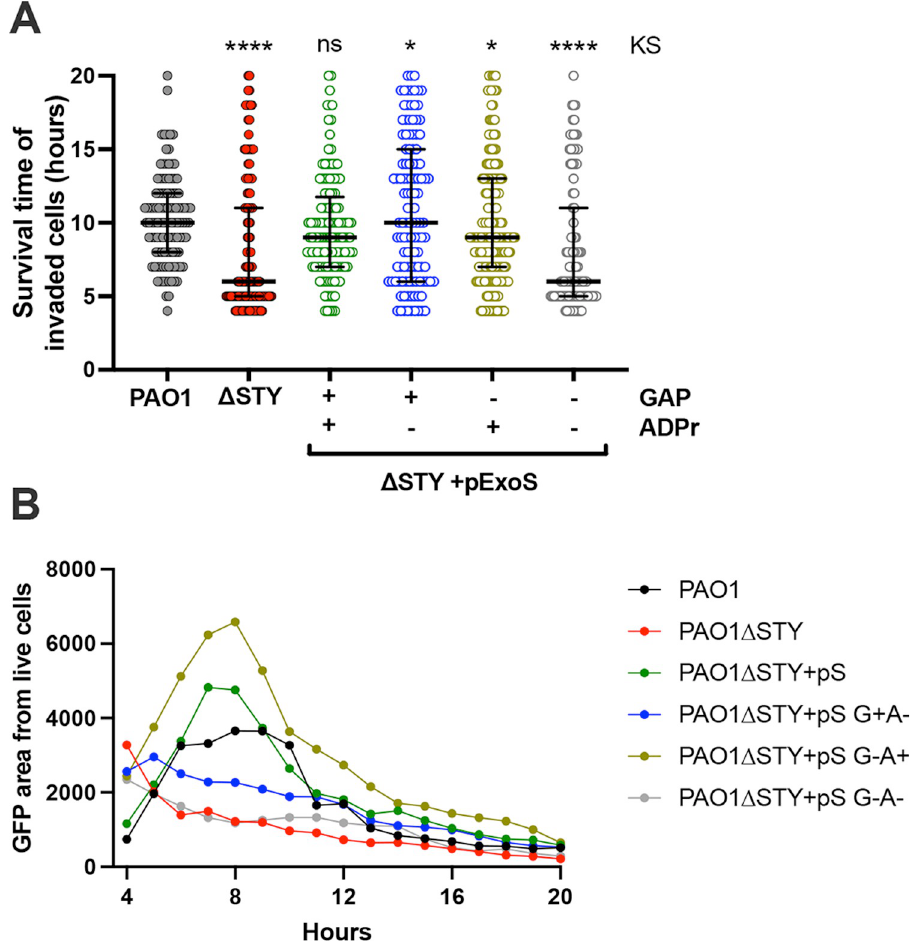
Fig 7. ExoS ADPr domain prolongs invaded host cell life and is sufficient for niche utilization. (A) Corneal epithelial cells were infected with PAO1, PAO1 Δ exoSTY or PAO1 Δ exoSTY complemented with ExoS on a plasmid with indicating enzymatic activities for 3 h, and extracellular bacteria then eliminated with amikacin. Hoechst and PI were included in the media and bacteria expressed the T3SS-GFP reporter. Time-lapse images were captured hourly from 4 to 20 h. Individual invaded cells were identified through the FIJI analysis macro and the time when nuclei became PI+ determined. Experiments were repeated twice, and a representative experiment is shown. (B) The area of GFP signal contained within only cells designated as alive was summed and plotted from the same data set as panel (A). Complementation of PAO1 Δ exoSTY with ExoS or ExoS with an active ADPr domain was associated with a significant intracellular presence similar to PAO1. Host cell survival data expressed as the median with IQR. Kolmogorov-Smirnov (KS) significance values versus PAO1, � P < 0.05, �� P < 0.01, ���� P < 0.001. an ExoS mutant lacking ADPr and RhoGAP activity mirrored the effector-null mutant. Interestingly, mutation of either one of the two domains increased host cell survival time (Fig 7A). However, when the analysis was done using intracellular GFP area (internalized bacteria, invaded cells), only ADPr-positive ExoS (i.e. intact ExoS or RhoGAP mutant ExoS) matched the wild-type PAO1 phenotype (up to 8 h post-infection). These results showed that while the ADPr activity of ExoS could protect invaded cells against cell death, protection provided by its RhoGAP domain (apparent only in the absence of its ADPr domain) was attributable to its antiphagocytic activity, similar to the RhoGAP domain of ExoT.